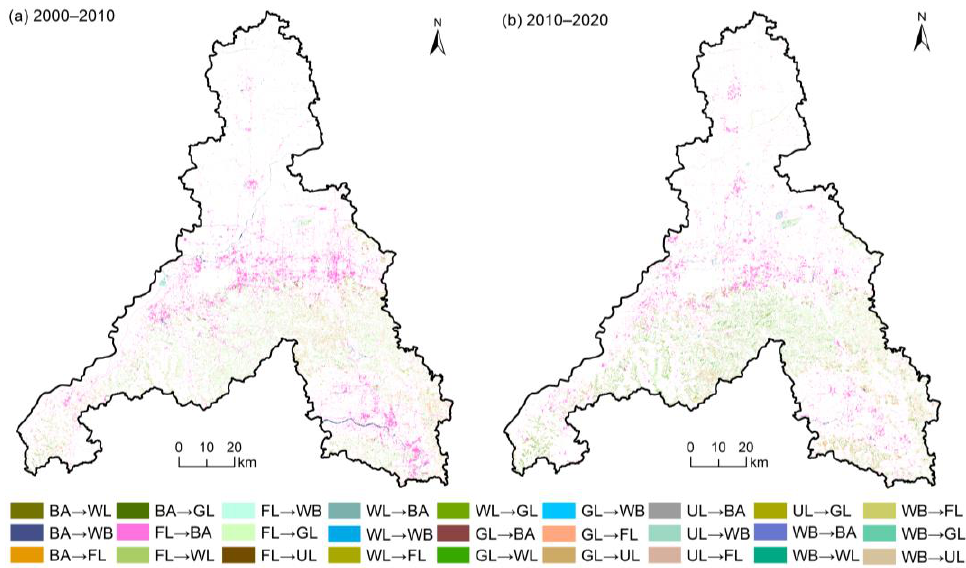
Figure 5. Spatial distribution of land use/land cover transfers in Jinan from 2000 to 2020: ( a ) shows the transfer results in the first decade; ( b ) shows the transfer results in the second decade.